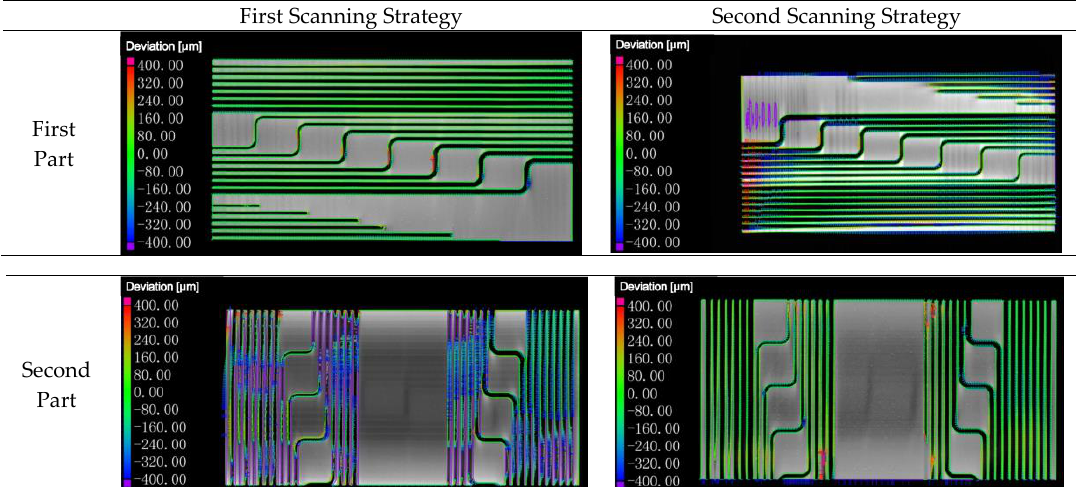
Figure 3. ( a ) The printed specimen and ( b ) the measured position in this work.